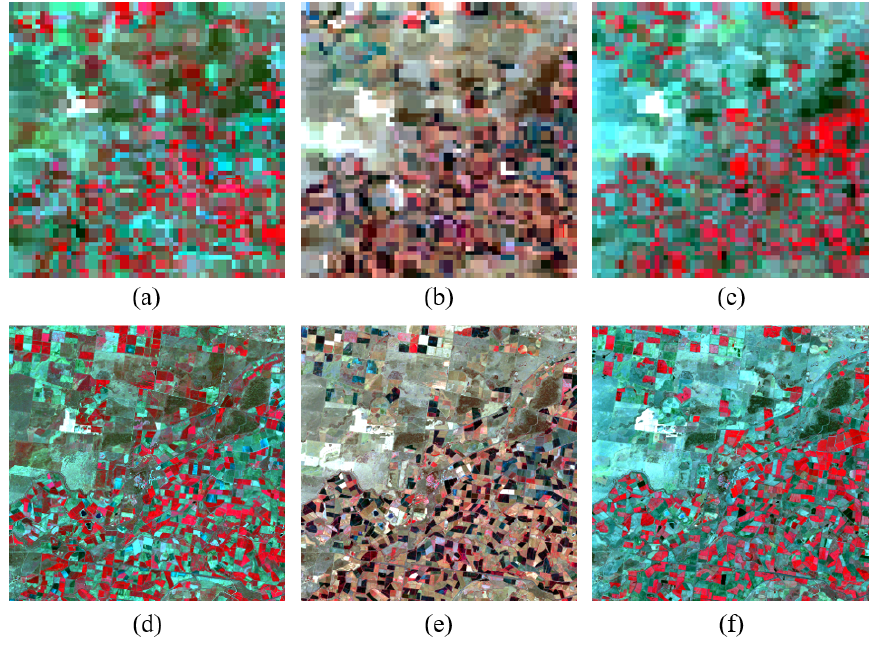
Figure 6. Comparison of CIA image pairs on 7 October 2001, 24 November 2001, and 9 March 2002. ( a , d ) are the MODIS and Landsat images on 7 October 2001, respectively. ( b , e ) are the MODIS and Landsat images on 24 November 2001, respectively. ( c , f ) are the MODIS and Landsat images on 9 March 2002,